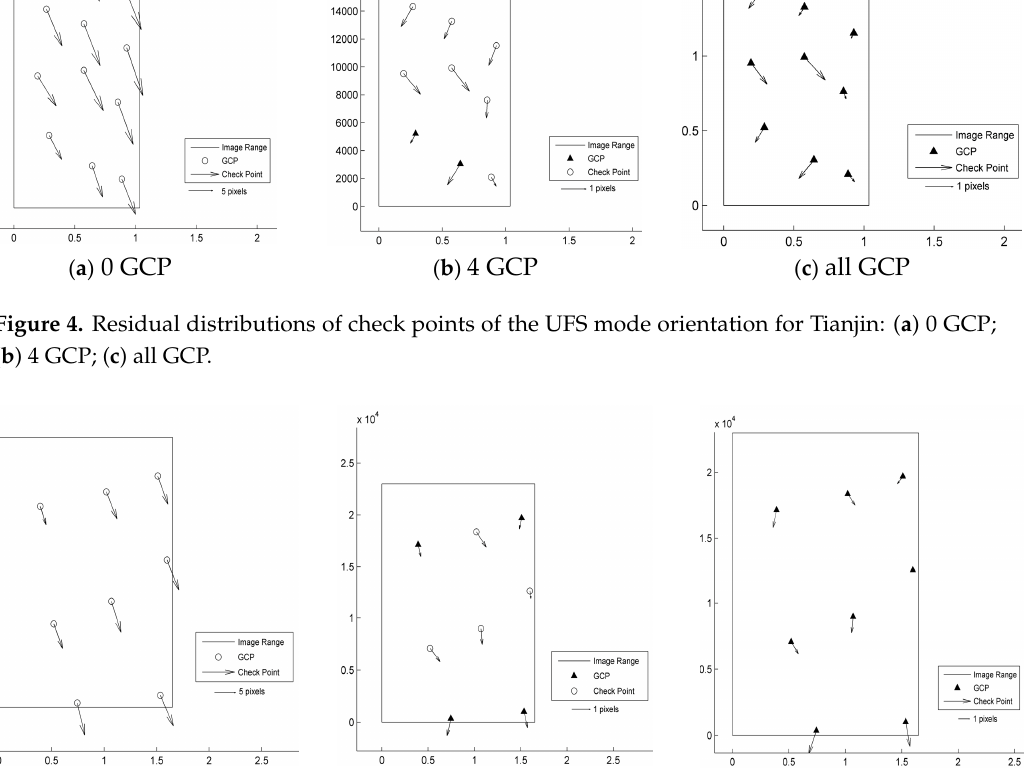
Figure 5. Residual distributions of check points of the FSI mode orientation for Mount Song: ( a ) 0 GCP; ( b ) 4 GCP; ( c ) all GCP.